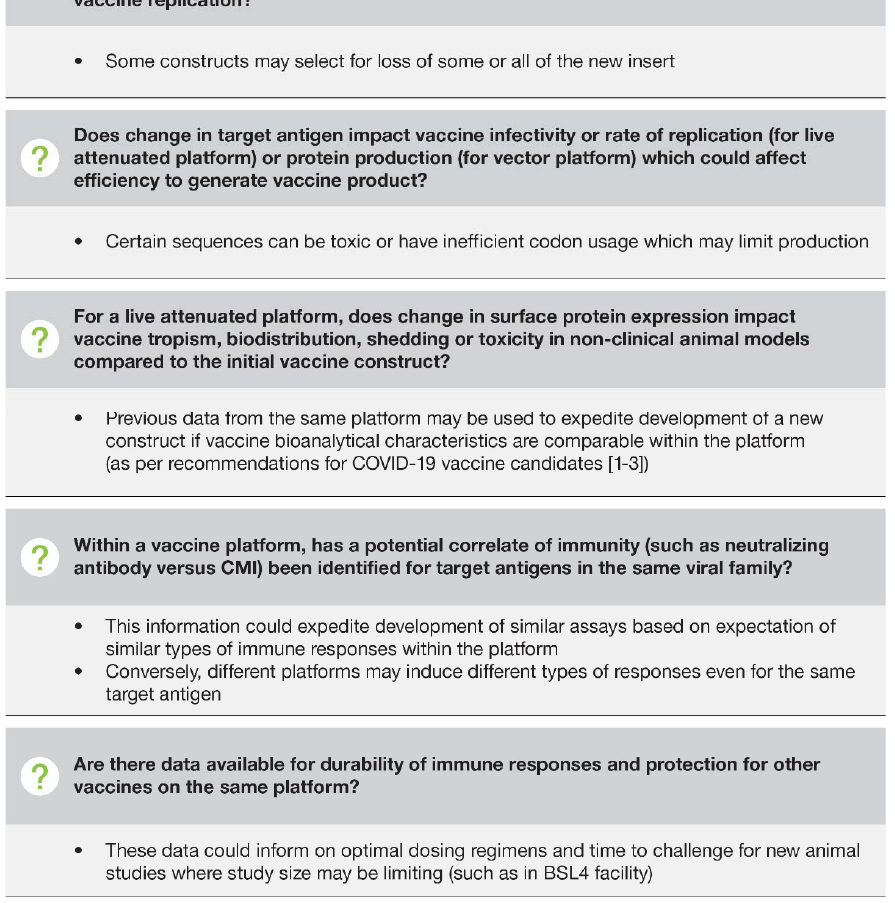
Figure 2. Key questions for new vaccine constructs based on shared platforms. BSL4, biosafety level 4; CMI, cell ‐ mediated immunity; EBOV, Zaire ebolavirus; GP, glycoprotein; MARV, Marburg virus.